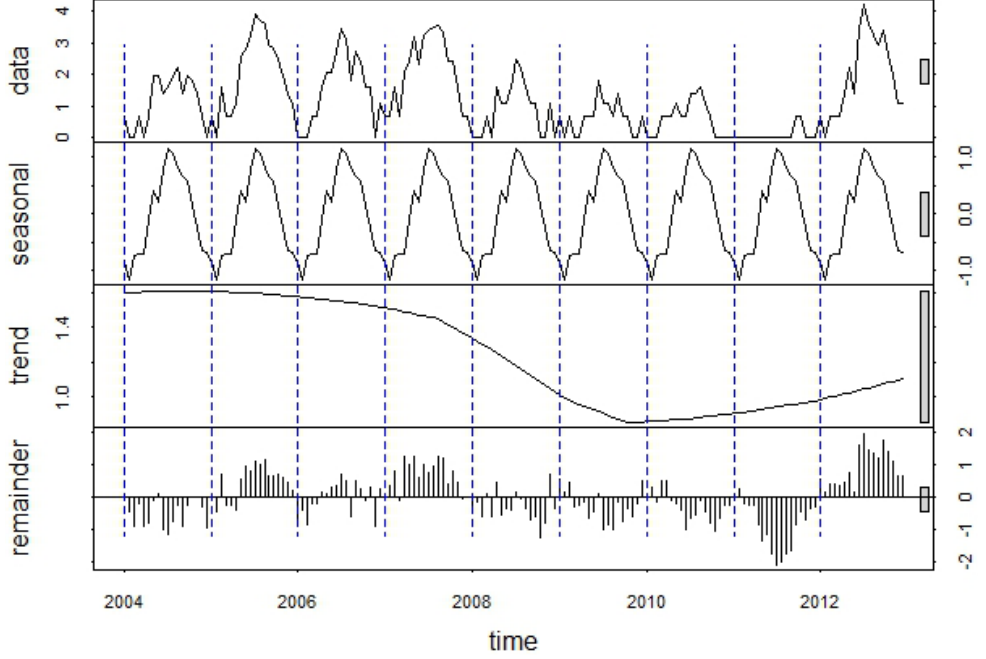
through the first week in October.